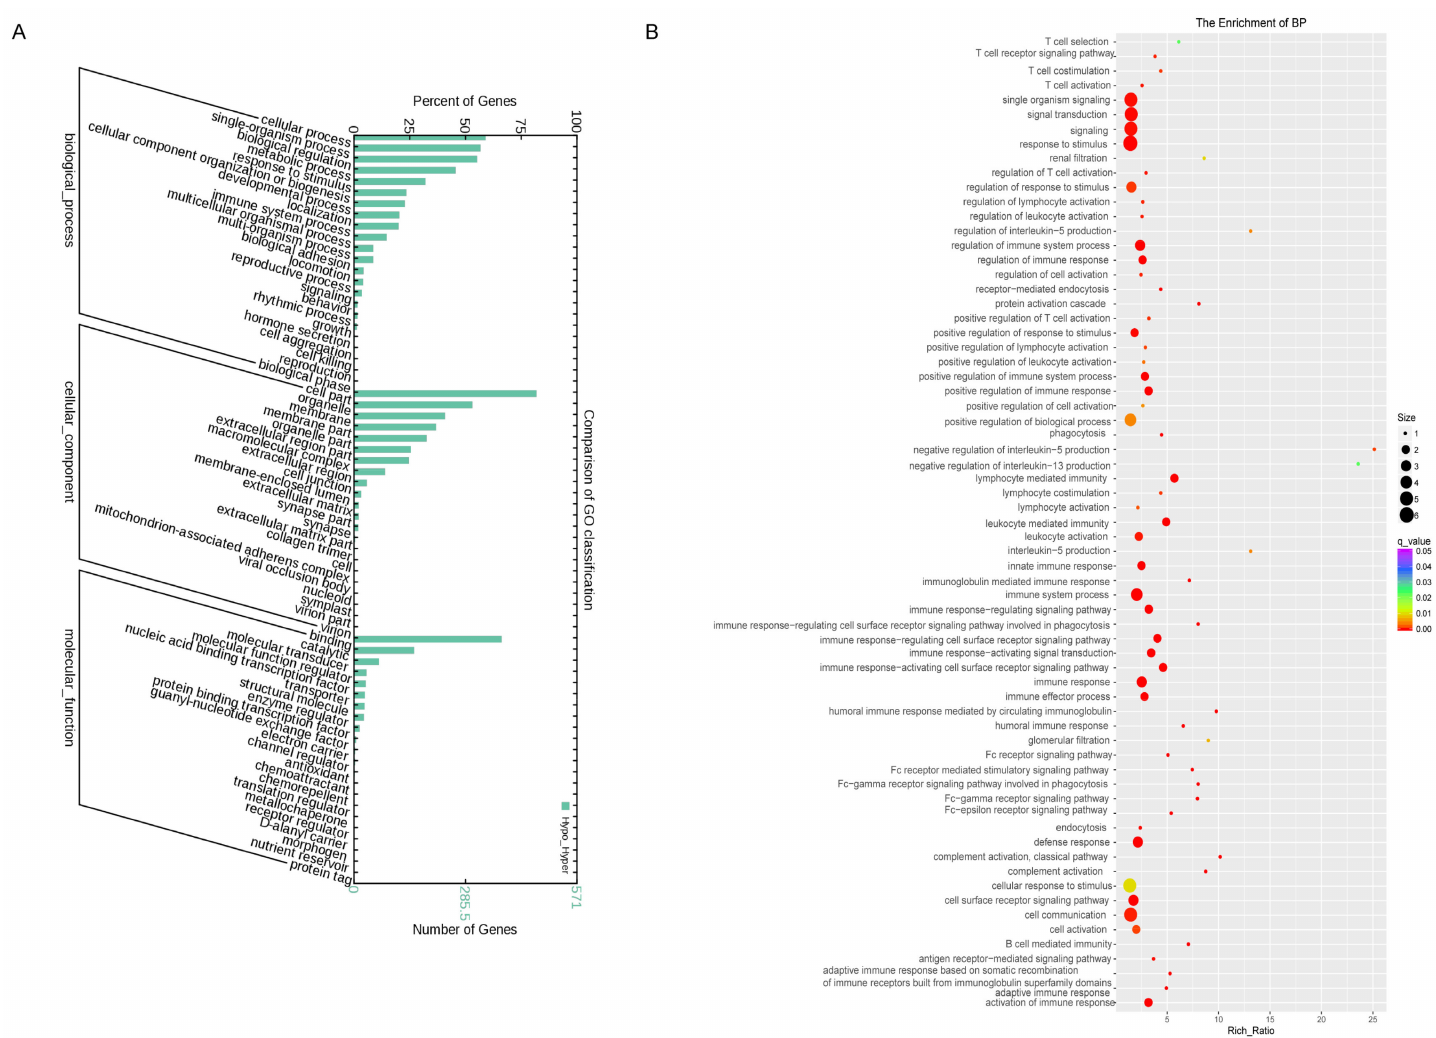
Figure 2. Gene ontology enrichment analysis of differentially expressed platelets mRNAs. ( A ) GO analysis of differentially expressed mRNAs in hyperreactive and hyporeactive platelets. ( B ) GO enrichment score graph of differentially expressed mRNAs in hyperreactive and hyporeactive platelets as regards biological